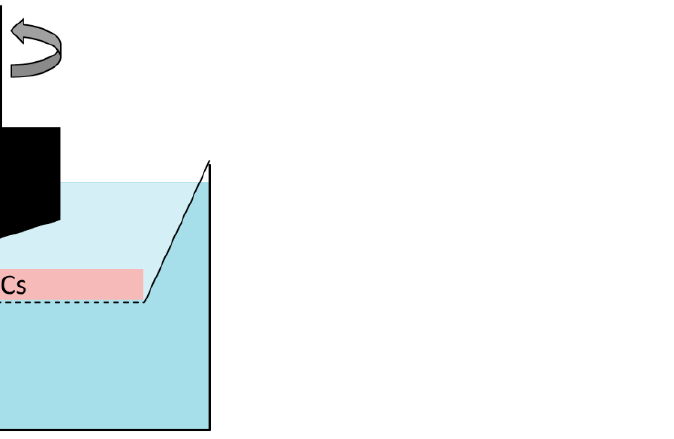
Figure 7. The cone–plate blood–brain barrier (BBB) apparatus. As a simple approach to simulate the effects of cerebral blood flow in static monolayer models, the cone-plate BBB apparatus uses a rotating cone to produce shear forces that reach the endothelial cells through the culture medium. This technique has limited reliability and is not widely used for BBB studies.